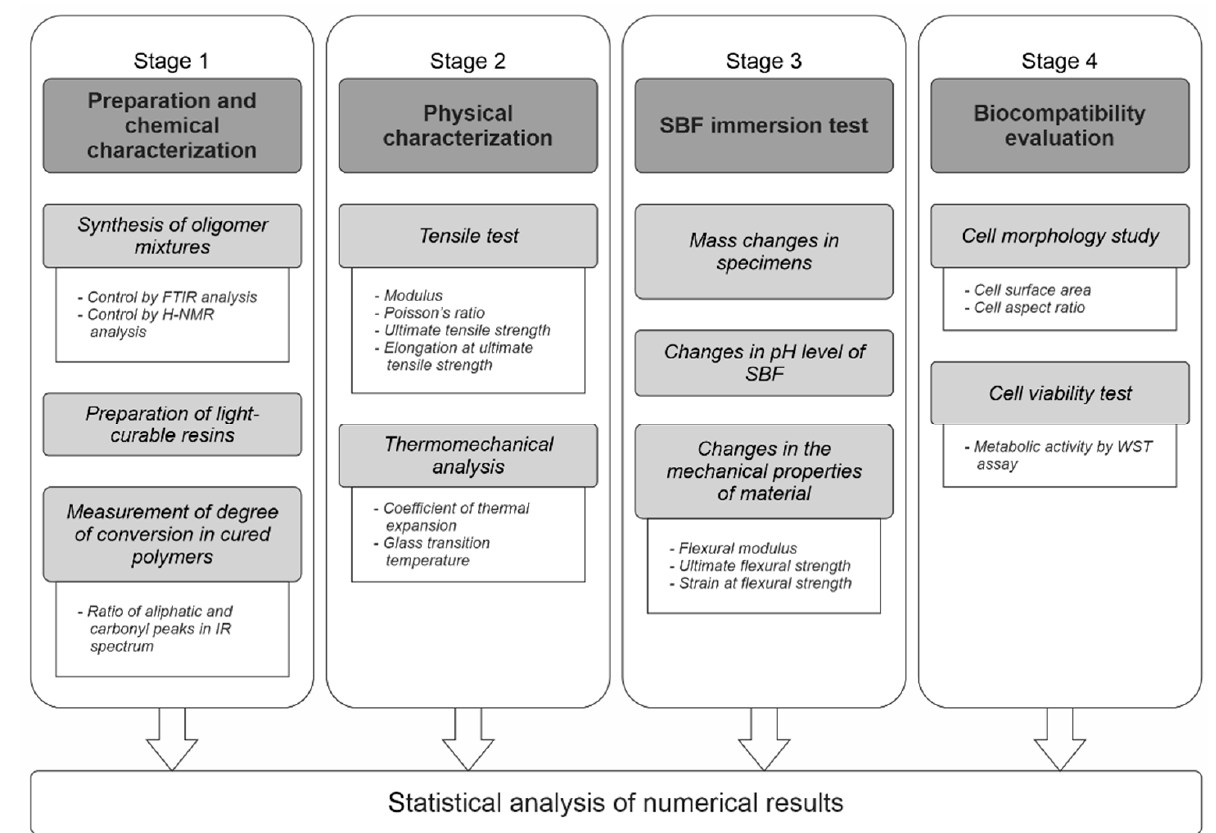
Figure 2. The overall workflow of the study.